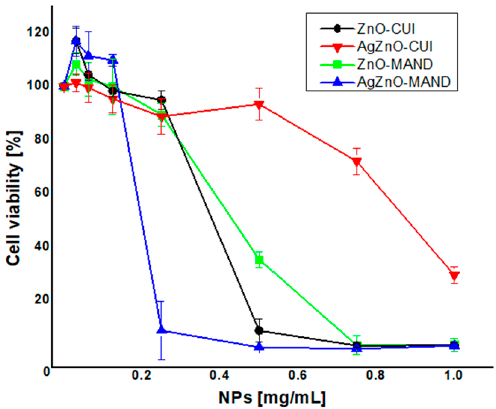
Figure 6. Cytotoxic effect of the samples on viability of BJ cells evaluated at 24 h using MTT assay. ZnO-MAND and ZnO-CUI samples showed a similar behavior against BJ cells, decreasing